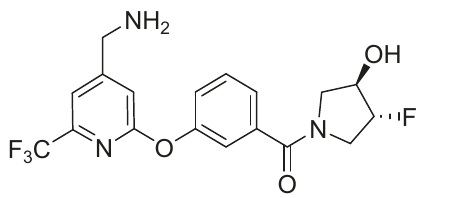
Fig. 4 In situ LOXs activity assay applied to aortic tissue samples. a Representative Western blot images of LOXL2, LOX, LOXL1 and LOXL3 expression in aortic matrix of young (Y, < 3 months old) and old (O, > 18 months old) wild-type (WT) and LOXL2 + / − littermate mice ( n = 8). AOC3 is detected in the cytosolic fraction of aortic tissue homogenates but not in ECM and AOC3 expression level is similar across four groups. GAPDH was used as loading control. Bar graph shows the densitometry analysis of Western blots (mean ± SEM; n = 6; * P < 0.05 by 2-way ANOVA). b Representative confocal Z-stack maximum projection immuno fl uorescence images show LOXL2 activity in aortic rings from young and old, WT and LOXL2 + / − mice. Freshly isolated aortic rings were incubated with 200 µ M biotin-hydrazide (BHZ) in DMEM + ITS for 24 h, then fi xed and stained for LOXL2 (red), LOXs activity (green), and nuclei (blue). ( n = 6; Scale bar = 100 μ m). c Representative confocal images of control aortic rings incubated without BHZ. Samples were stained for LOXL2 (red), endogenous biotinylation (green), and nuclei (blue). ( n = 6; Scale bar = 100 μ m). d Bar graph of LOXs activity calculated as mean gray value of the IF images (mean ± SEM; n = 12, * P < 0.05 by 2-way ANOVA). The overall LOXs activity in each group corresponds positively to the expression levels of LOXs in aortic ECM shown in a